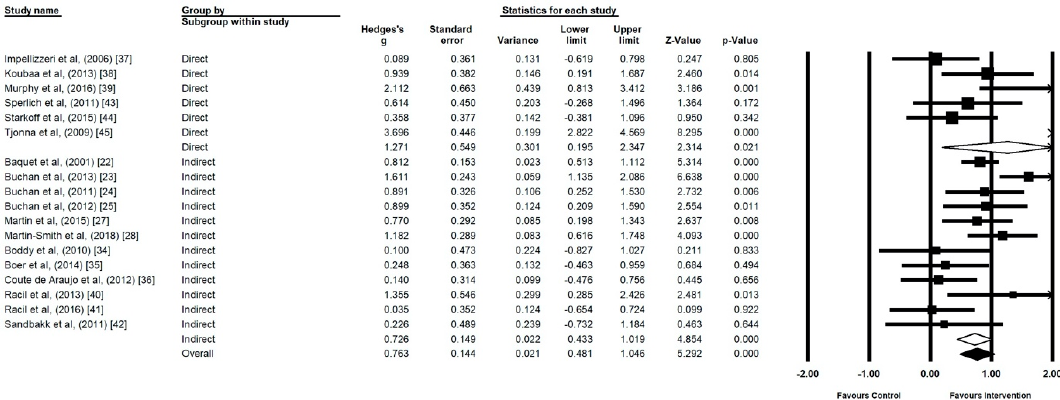
Figure 5. Forest Plot of the Comparison of effect size of high intensity interval training (HIIT) and sprint interval training (SIT) on cardiorespiratory fitness (CRF) of studies assessing CRF via direct measurement of expired gases or indirect prediction.